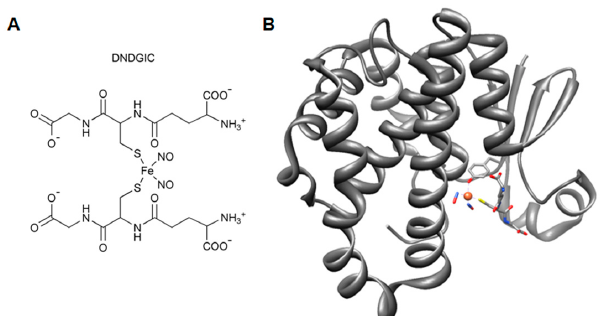
Figure 4. The interaction of the dinitrosyl-diglutathionyl iron complex (DNDGIC) with GSTP1-1. ( A ) chemical structure of DNDGIC. ( B ) three-dimensional structure of the dinitrosyl-glutathionyl iron complex ( ball-and-stick) bound to a monomer of GSTP1-1 ( dim-grey ribbons) (one GSH is replaced by a Tyr residue, which completes the coordination shell of the iron ion with its oxydril group) (PDB id: 1zgn) [12] .